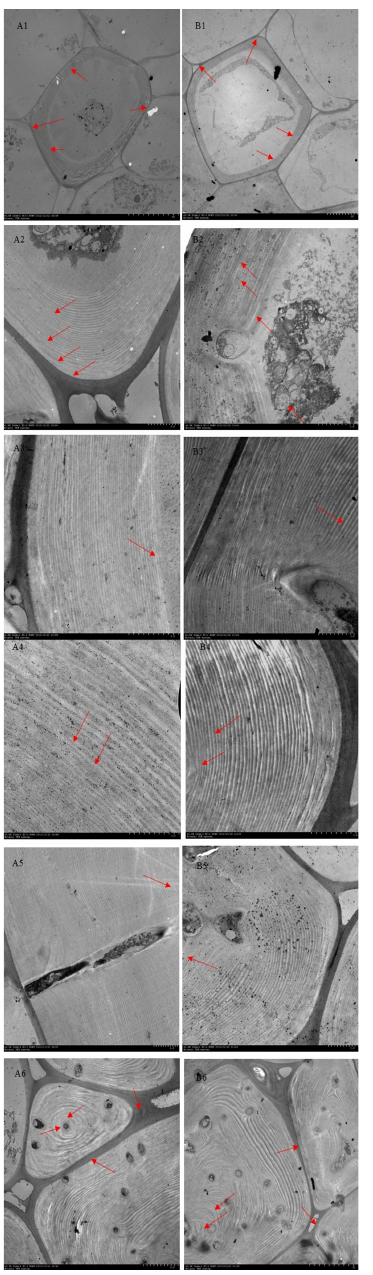
FIGURE 5 Ultramicroscopy of lignin deposition during stone cell development of DY and DW. Note: (A1 – A6) 23d, 31d, 39d, 47d, 55 d and 63 days after fl owering of DY, respectively; (B1 – B6) 23d, 31d, 39d, 47d, 55d and 63 days after fl owering of DW, respectively. (A1,B1) Lignin was unevenly deposited along the primary walls fi ne particles at the corner of the primary cell wall; (A2-A3,B2-B3) Deposition initiates from the inside of the S1 layer to S2 layer; (A4-A5, B4-B5) Lignin particles were deposited unevenly along the inside of each micro- fi bril in every S 2 layer; (A6,B6) Lignin was fully occupied the cell cavity; CC: cell corner; CIL: composite intercellular layer; S 1 : S 1 layer of the secondary wall; S 1 L: layer between S 1 and S 2 ; S 2 : S 2 layer of the secondary wall; S 2 L: layer between S 2 and S 3 ; S 3 : S 3: layer of the secondary